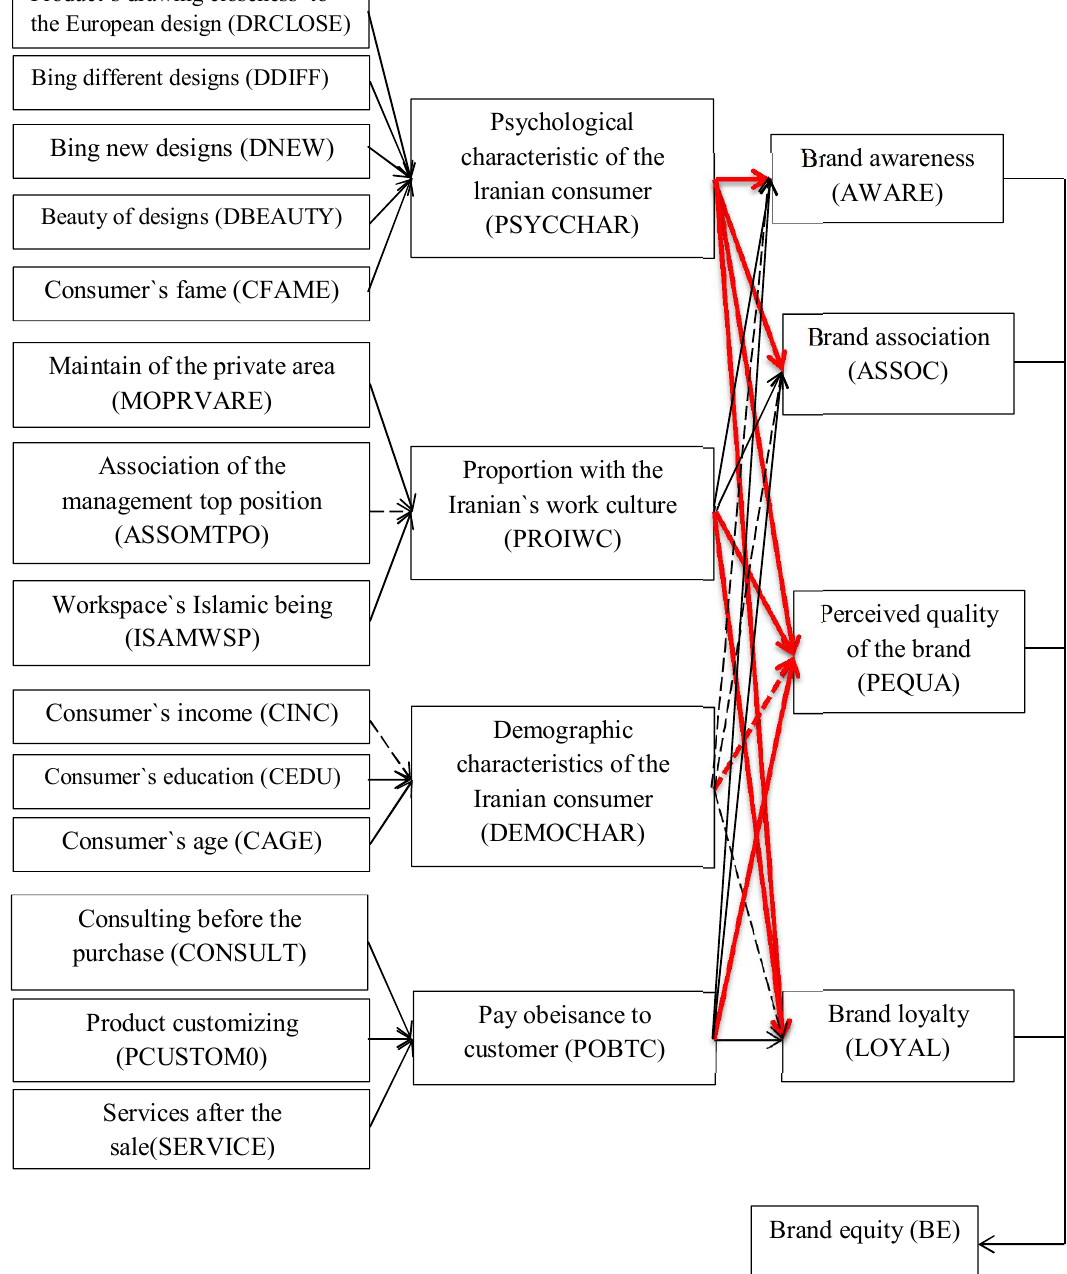
Fig. 3. Research final